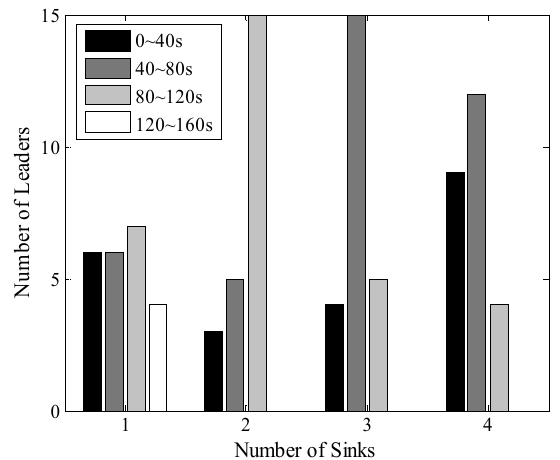
Figure 26. Time interval of two consecutive times of data upload (100 m × 100 m, 200 nodes).